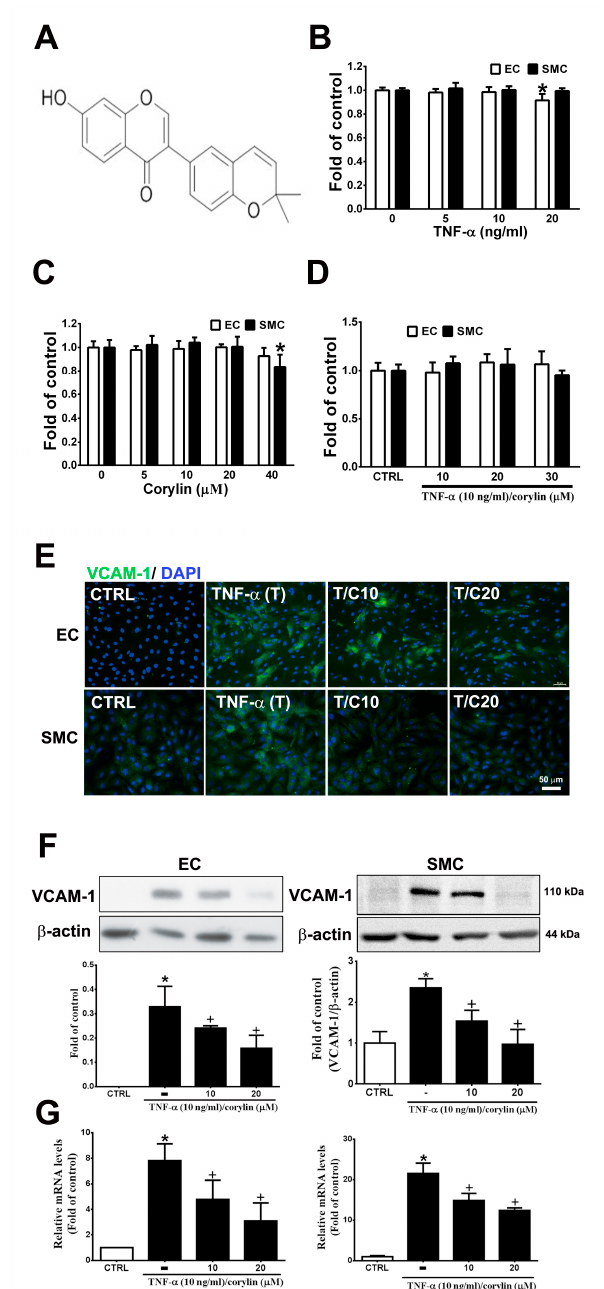
Figure 1. Corylin reduces inflammation in tumor necrosis factor- α (TNF- α )-treated human umbilical vein endothelial cells (HUVECs) and vascular smooth muscle cells (VSMCs) by downregulating vascular cell adhesion protein-1 (VCAM-1) expression. ( A ) Chemical structure of corylin. HUVECs and VSMCs were treated with 0, 5, 10, or 20 ng / mL TNF- α alone for 24 h ( B ), 0, 5, 10, 20, or 40 µ M corylin alone for 24 h, ( C ) or pretreated (1 h) with 10, 20 or 30 µ M corylin and then treated with 10 ng / mL TNF- α for 24 h. ( D ) SRB assay was performed to observe cell viability. ( E , F ) Immunofluorescence staining and Western blot analysis were performed to evaluate the level of VCAM-1 protein expression. β -actin was used as an internal control for sample loading. Nuclei were labeled with DAPI (blue). ( G ) Quantitative real-time PCR was performed to evaluate the VCAM-1 mRNA expression. HUVECs or VSMCs were pretreated (1 h) with 10 or 20 µ M corylin (C10 or C20) and then treated with 10 ng / mL TNF- α (T) for 6 h. The data are shown as the mean ± SD. * p < 0.05 versus the untreated group (CTRL). † p < 0.05 versus the TNF- α -treated group. Scale bars = 50 µ m ( E